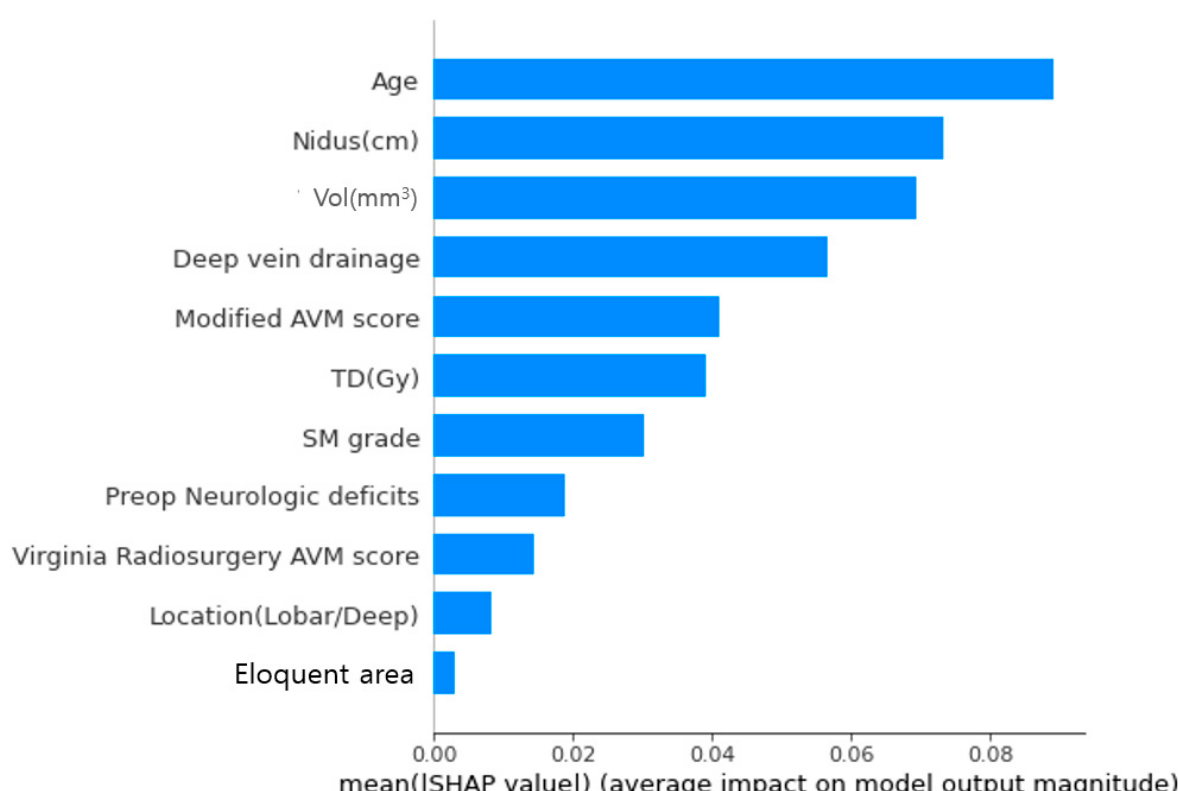
Figure 2. Feature importance for prediction of nidus obliteration.